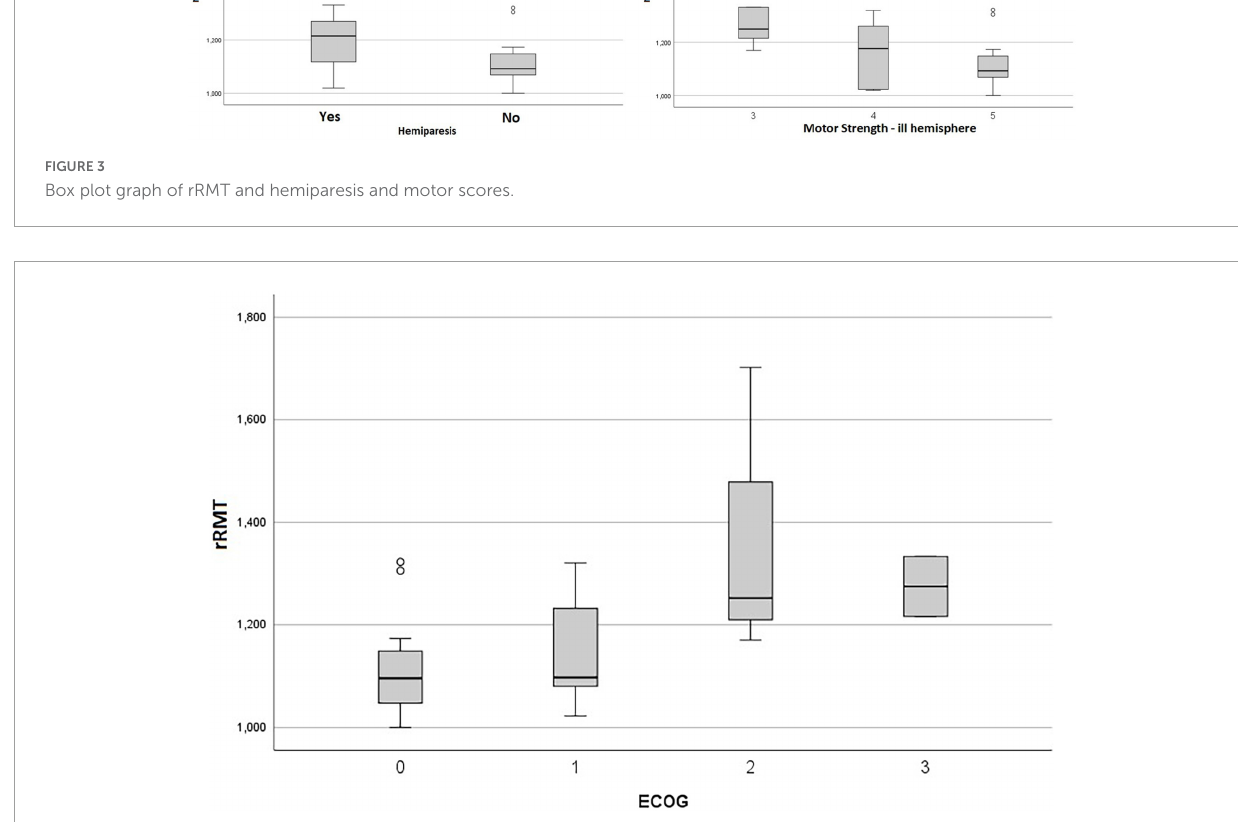
FIGURE4 Box plot graph of rRMT and